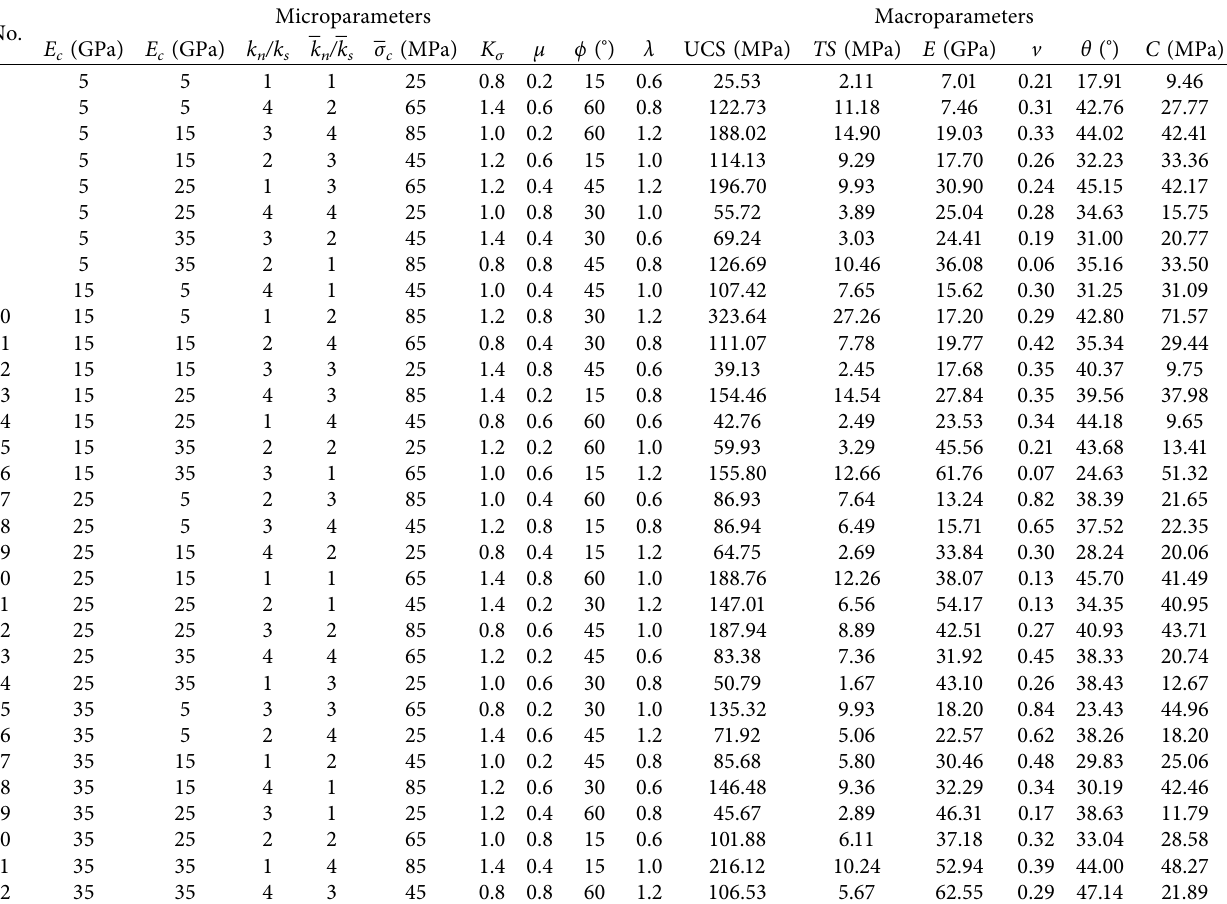
Table 5: Numerical calculation scheme and results based on the orthogonal experimental